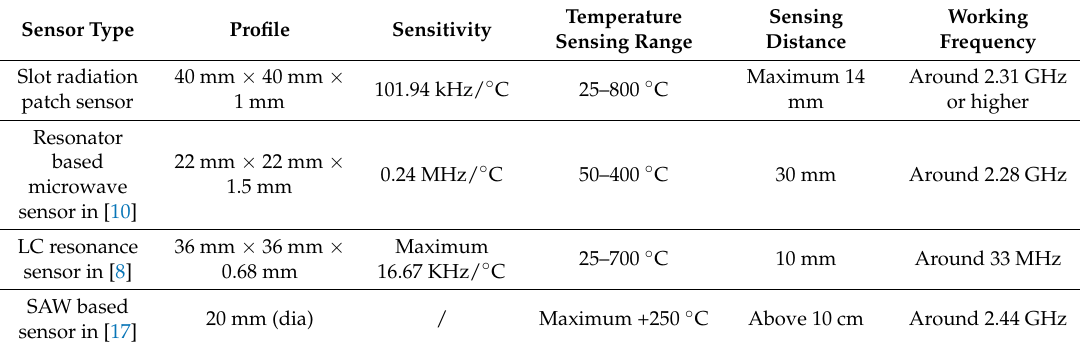
Table 2. Parameters of different temperature sensors.